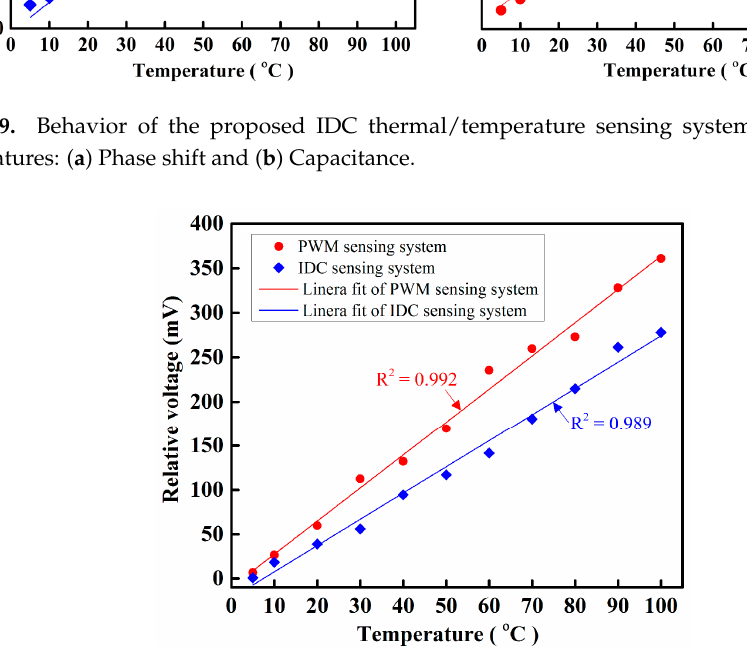
Figure 10. Temperature response of the proposed sensing systems .